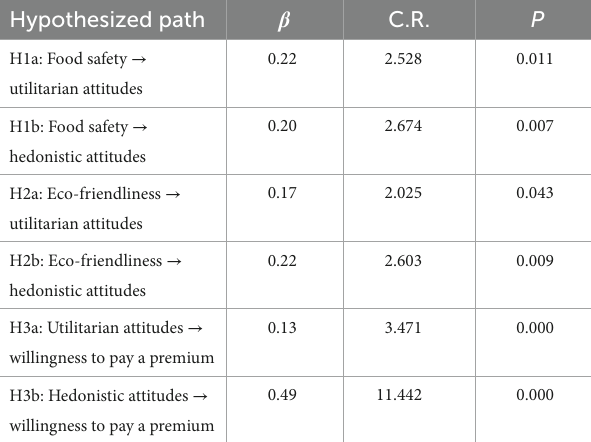
TABLE 5 Results of structural model analysis.